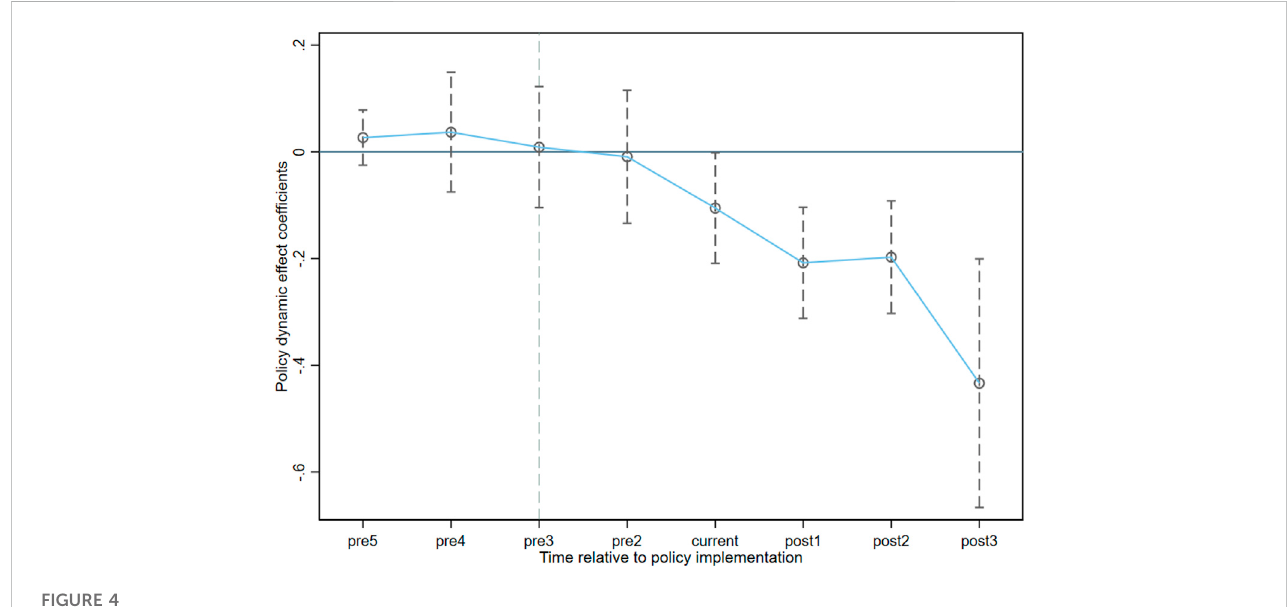
FIGURE 4 Parallel trend test results.